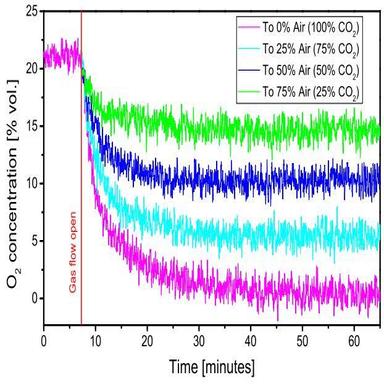
Diffusion of CO2 into pure air dispersed in polystyrene foam sample.